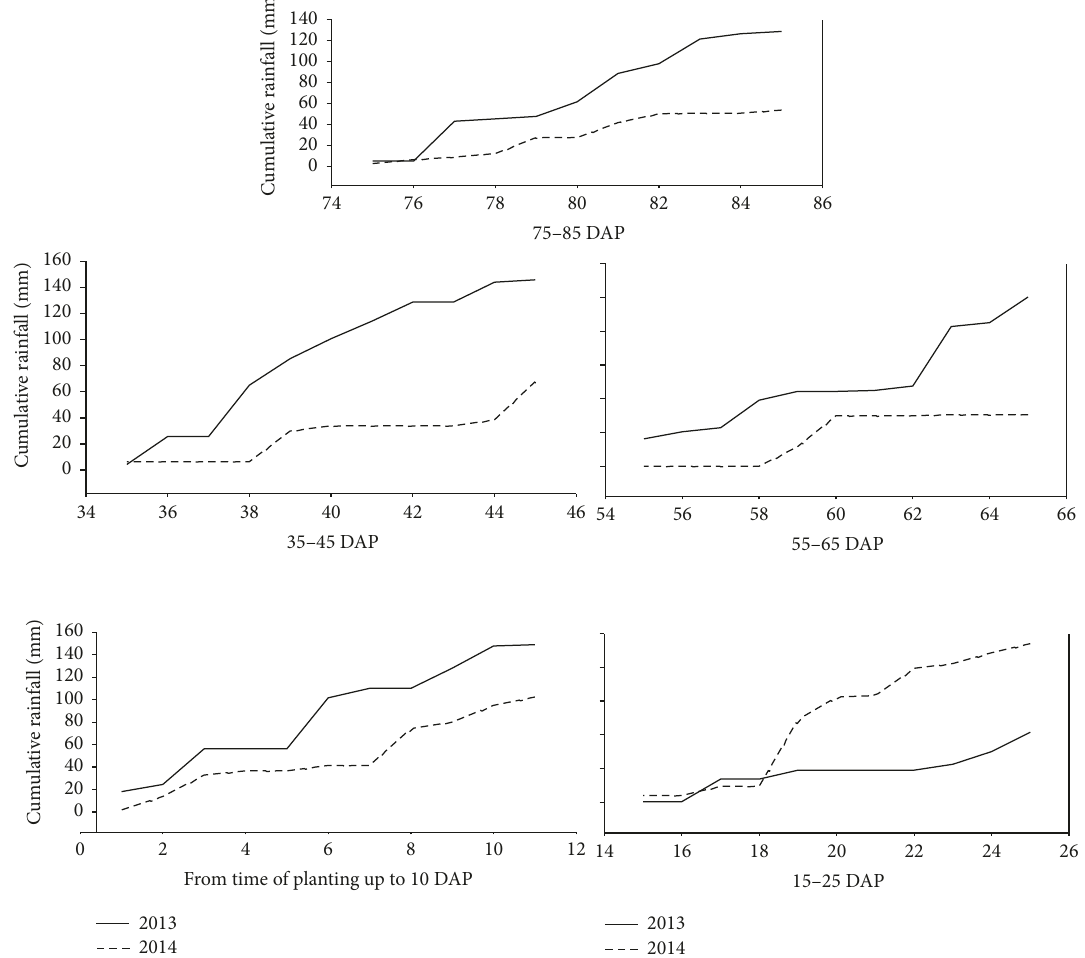
Figure 5: Cumulative rainfall distribution in different proposed N application times in 2013 and 2014 rainy seasons.